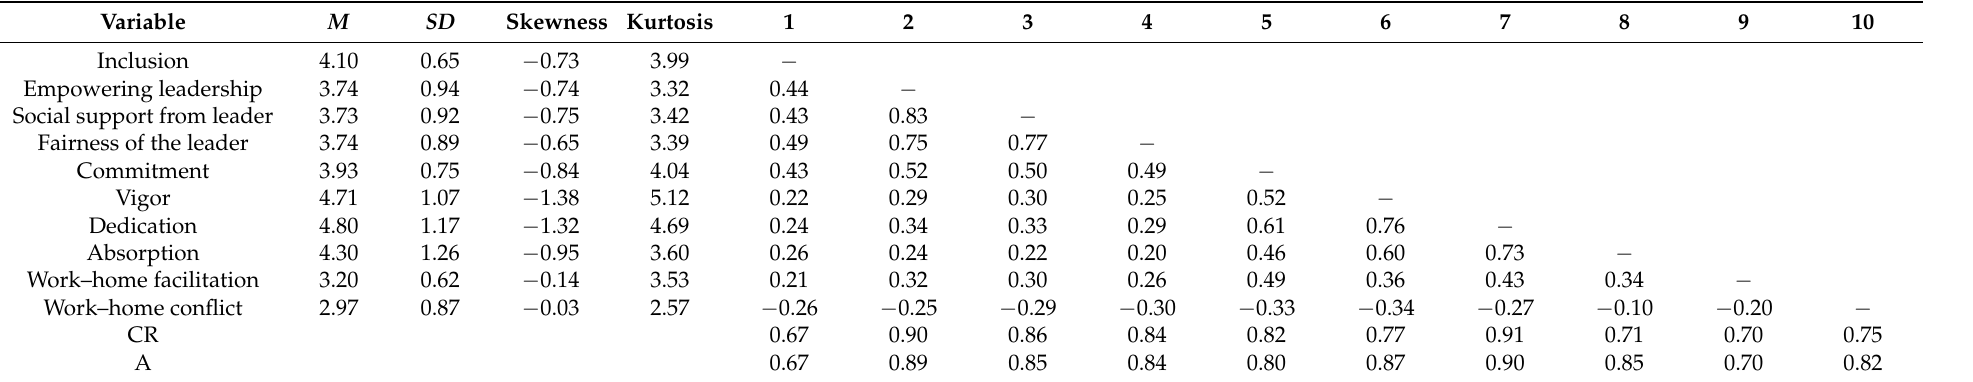
Table 1. Pearson’s correlations and scale reliabilities between the factors in the measurement